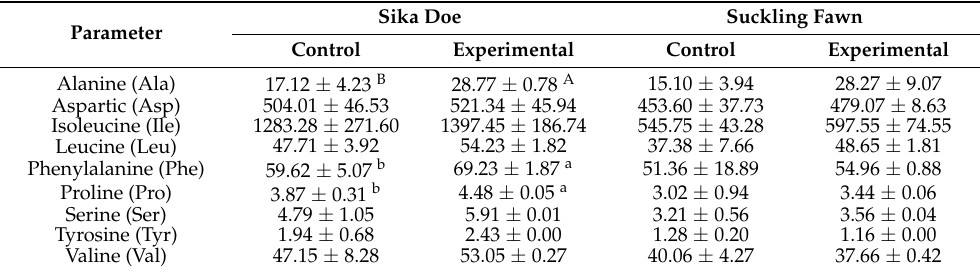
Table 6. Plasma amino acid of sika doe and suckling fawn ( µ